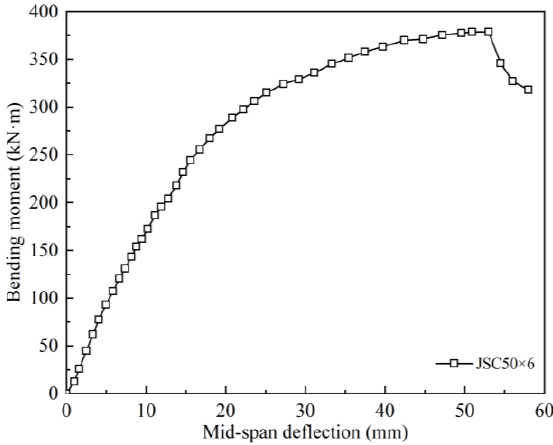
Figure 10. The bending moment – midspan deflection curve of the JSC50 × 6 component.